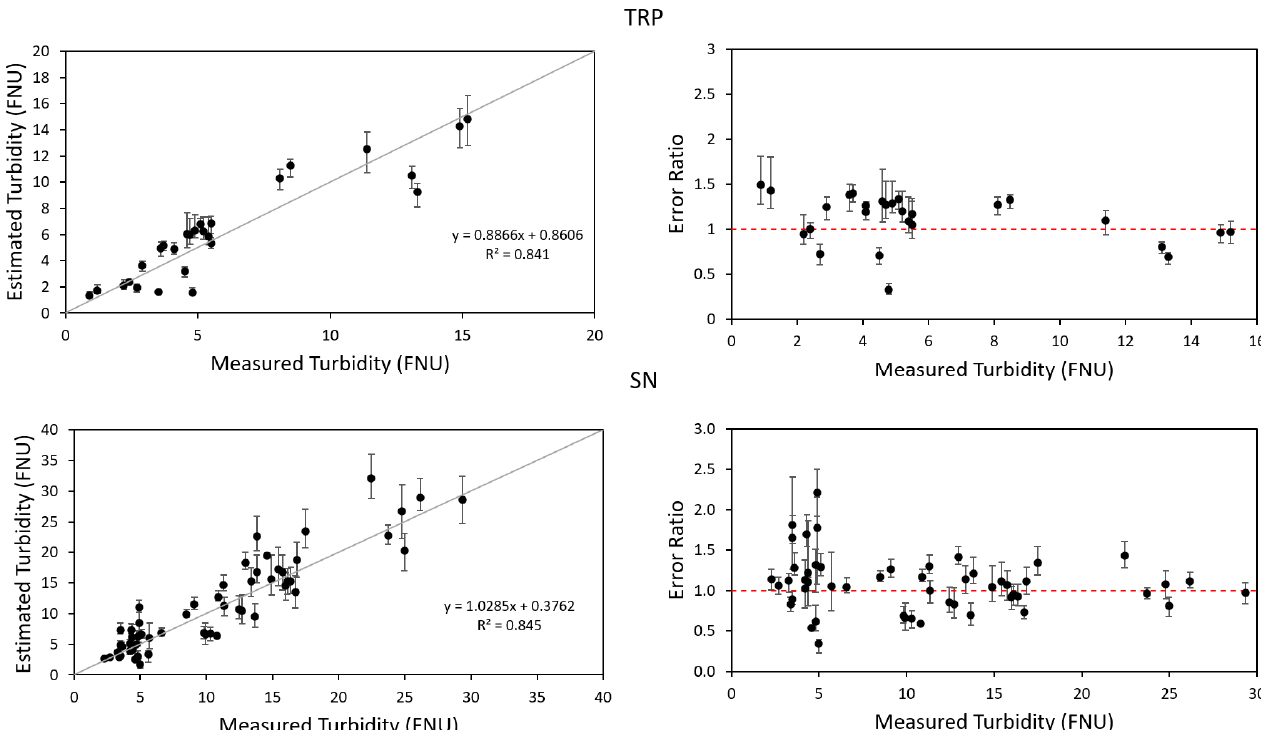
Figure 16. ( Left ) panels: scatter plot of measured turbidity versus turbidity estimated from the conversion of backscatter from bottom-mounted ADCPs for TRP and SN stations. ( Right ) panels: plots of the measured turbidity versus error ratio for TRP and SN stations. Grey solid lines are the 1:1 lines; the red dashed line represents the error ratio equal to 1. The black dots represent 4-beam averaged turbidity from ADCP data. The error bars in all plots represent the range of the four ADCP beams estimates (min and max values).